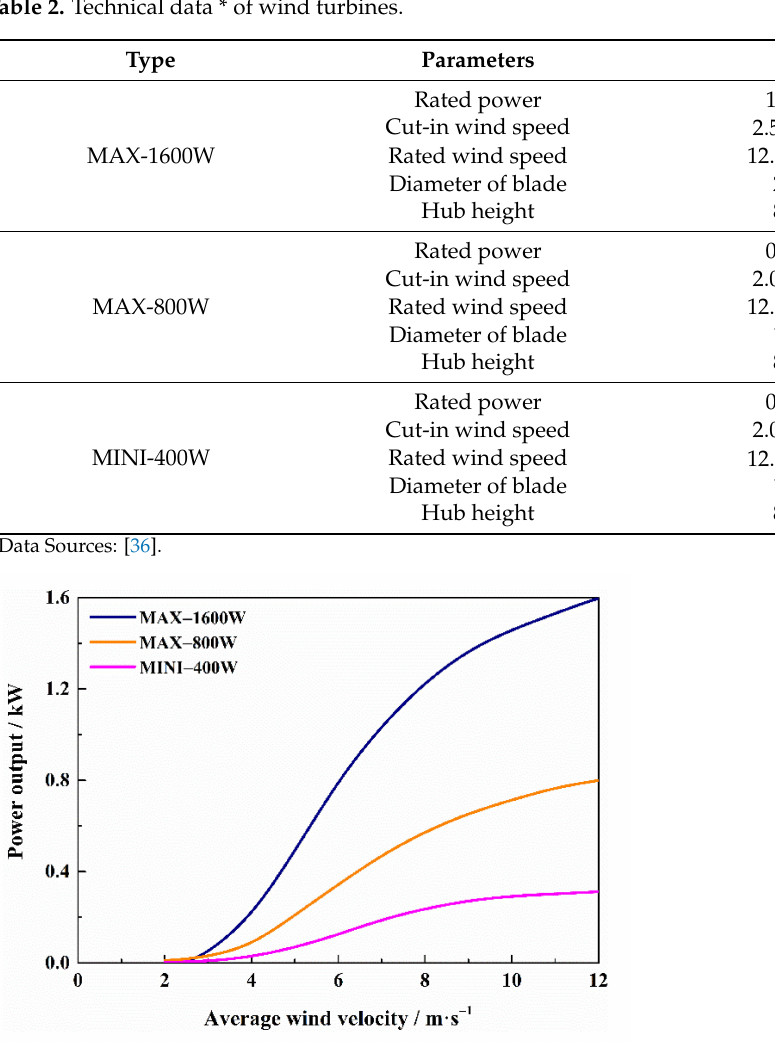
Figure 2. Power output curves of wind